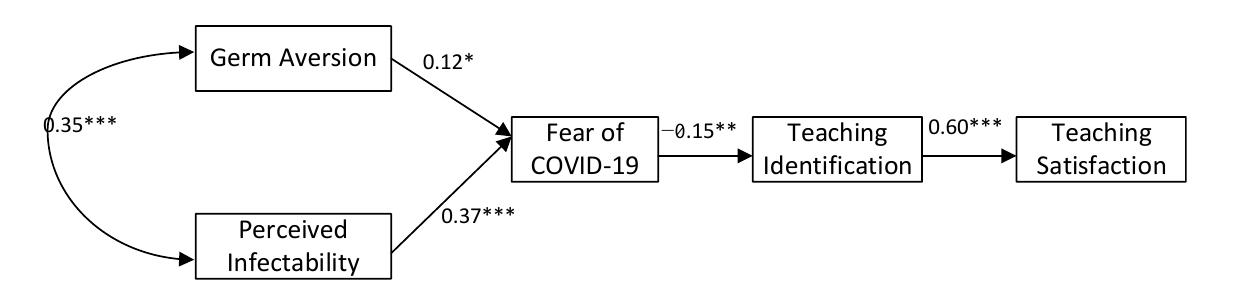
Figure 1. Structural equation model of serial mediation. * p < 0.05, ** p < 0.01, *** p < 0.001. The results of the structural equation model are reported in Table 2. Table 2. Direct and indirect effects of the predictor variables and mediator.